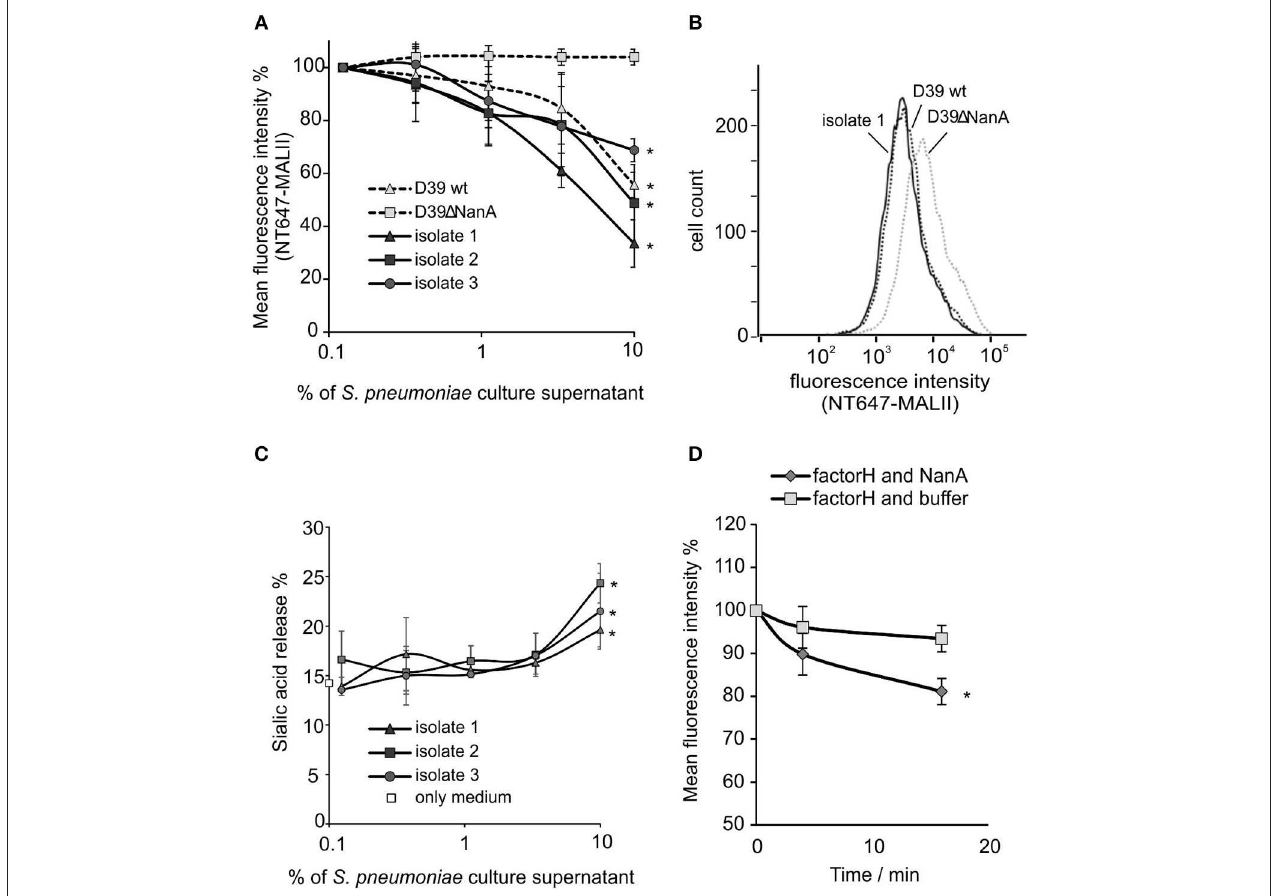
FIGURE 2 | Removal of sialic acids from cell surfaces by S. pneumoniae culture supernatants. 5 × 10 6 HEK cells were incubated with increasing volumes (% of supernatant in total volume of the sample) of S. pneumoniae late log-phase culture supernatants from wild type D39 strain (D39 wt), D39 nanA deletion mutant (D39 1 NanA) and three clinical isolates (isolate 1–3). Sialic acid removal was detected by flow cytometry using (A,B) sialic acid specific NT647-labeled MAL-II lectin or (C) by detecting free sialic-acid in the supernatant by thiobarbiturate acid at 450/532nm. (B) Histogram showing distribution of MALII-binding on HEK cells in the presence of supernatants from D39 wt, D39 1 NanA and isolate 1. Levels are calculated as (A) relative mean fluorescence intensity of NT647-MAL-II without culture supernatant ( n = 3) or (C) with 1.3 µ M of C. perfringens neuraminidase. (D) Removal of factor H from U937 cell surface by NanA. Fluorescence intensities of U937 cells, that were preincubated with 300nM NT647-labeled factor H, were detected with flow cytometry at different time points during incubation of the cells with or without NanA (150nM) ( n = 3). Relative mean fluorescence intensities of the samples are shown. Statistical significance (A) against MALII binding to D39 1 NanA cells or (C) sialic acid release % (D) or FH binding with only medium or buffer was calculated using One-way ANOVA (* P -value < 0.05). Error bars indicate SD.